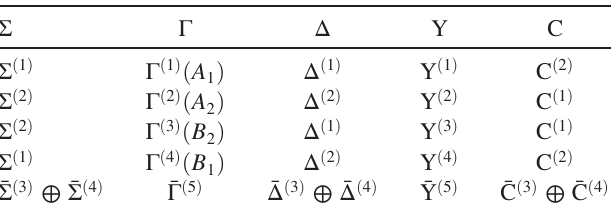
TABLE I. Compatibility relations along the highlighted cuts and adjacent points in Fig.